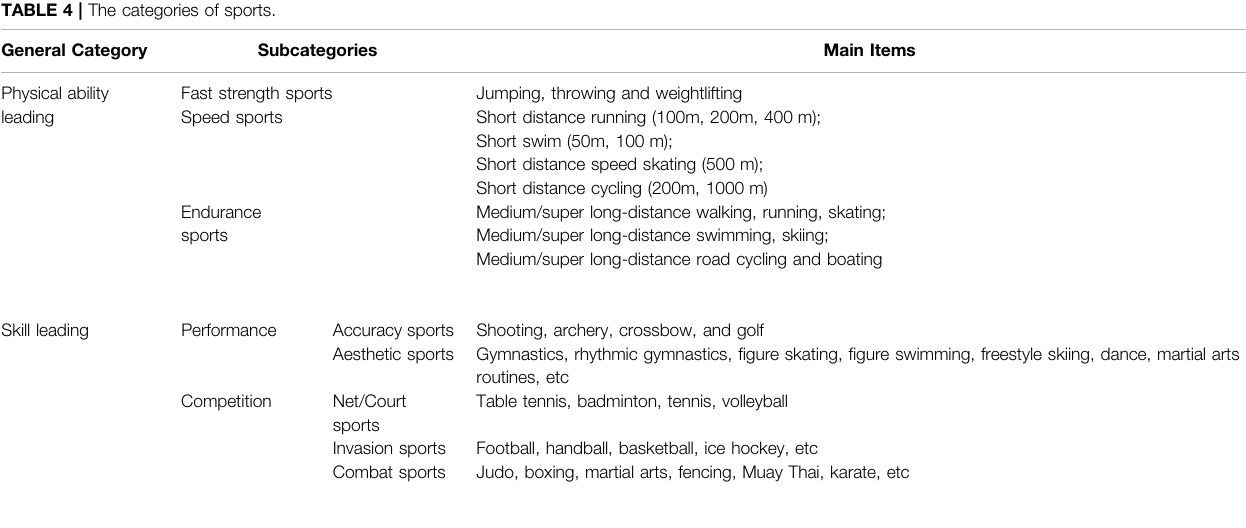
Table tennis, badminton, tennis,